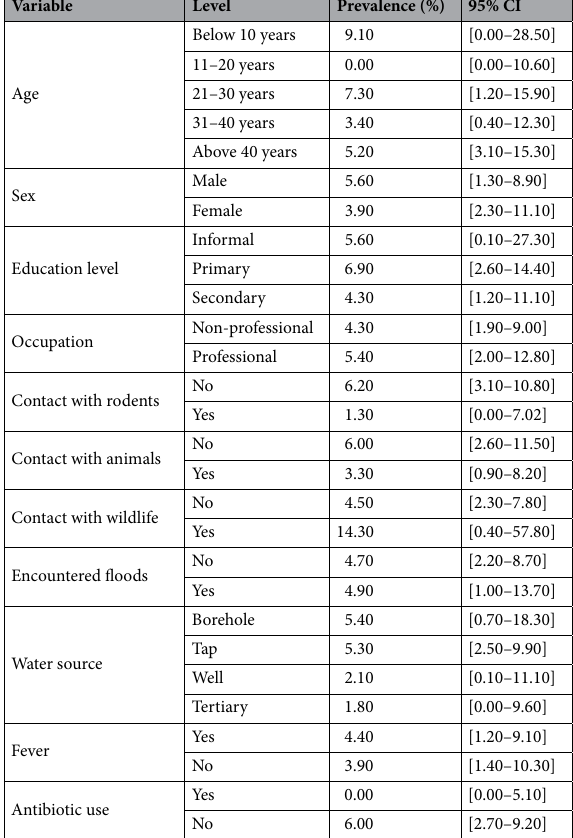
Table 1. Prevalence across patient characteristics table. Where CI is confidence interval; professionals = all participants with a minimum of certificates in relation to their occupation; non-professionals = participants without a minimum of a certificate in relation to their